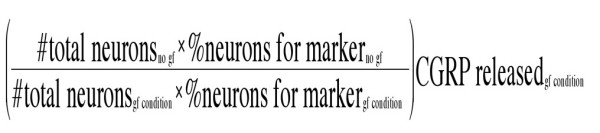
Equation used to normalize CGRP release. "No GF" refers to no growth factor controls and "GF condition" refers to any given growth factor treated condition